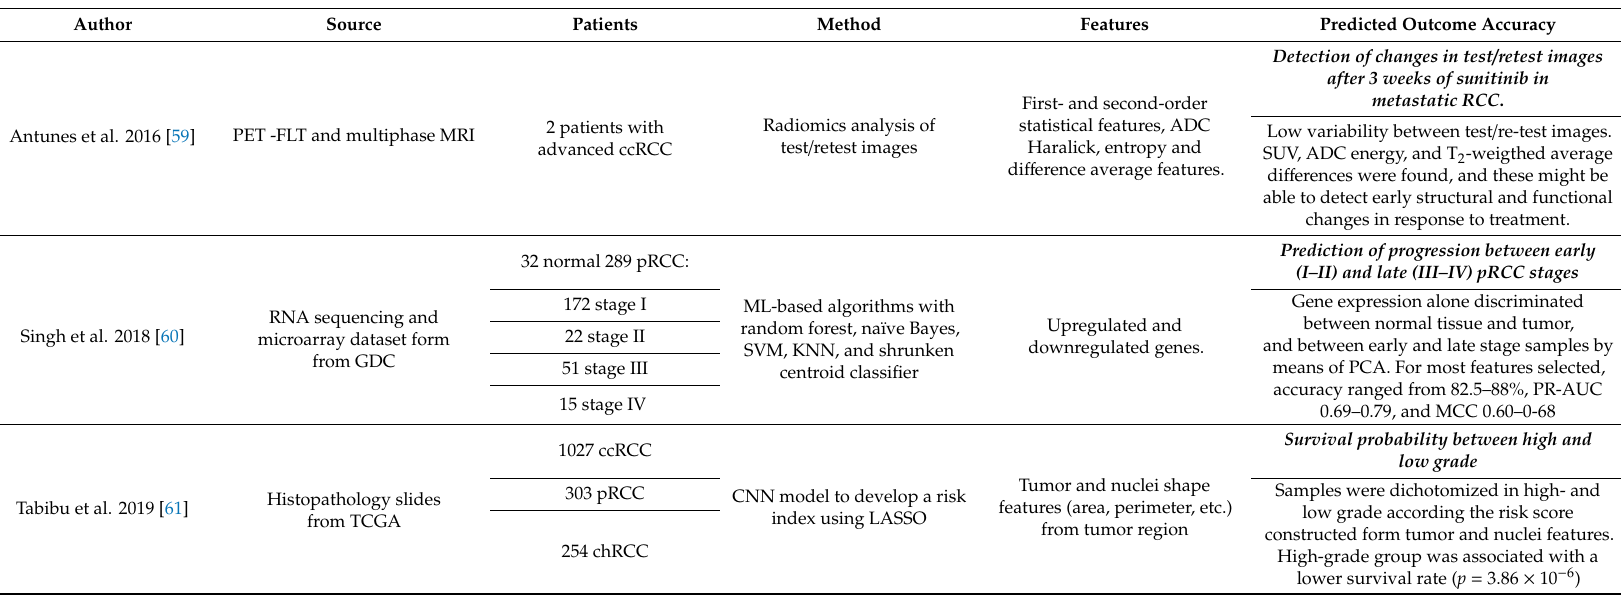
Table 4. Summary of studies applying radiomics and gene expression-based models to predict progression in